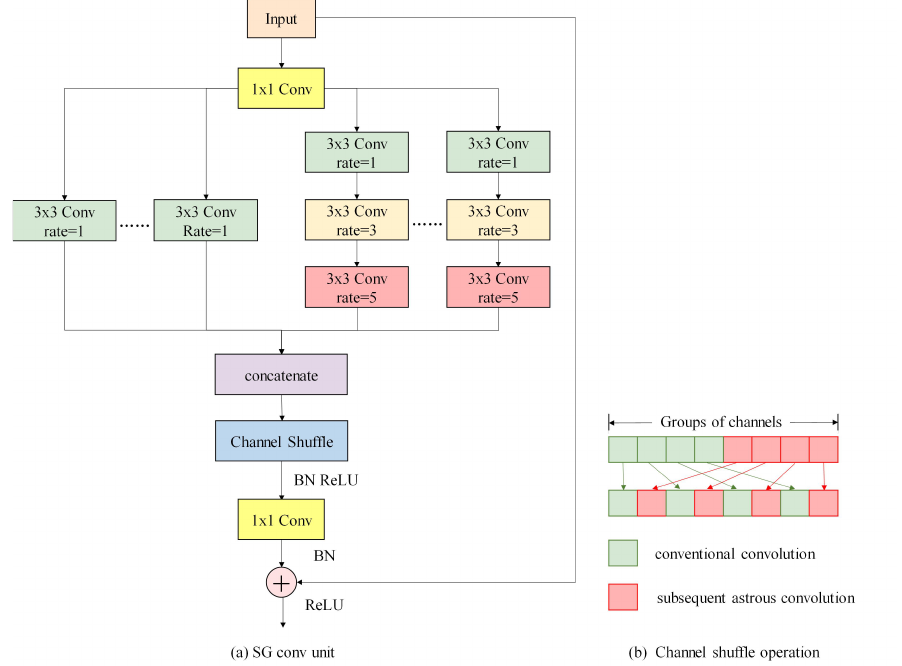
Figure 2. SG conv unit: ( a ) A SG conv unit has a 1x1 convolution, group convolution layers followed by channel shuffle, another 1x1 convolution, and a shortcut connection. ( b ) Channel shuffle operation in the SG conv unit mixes groups that have conventional convolution and atrous